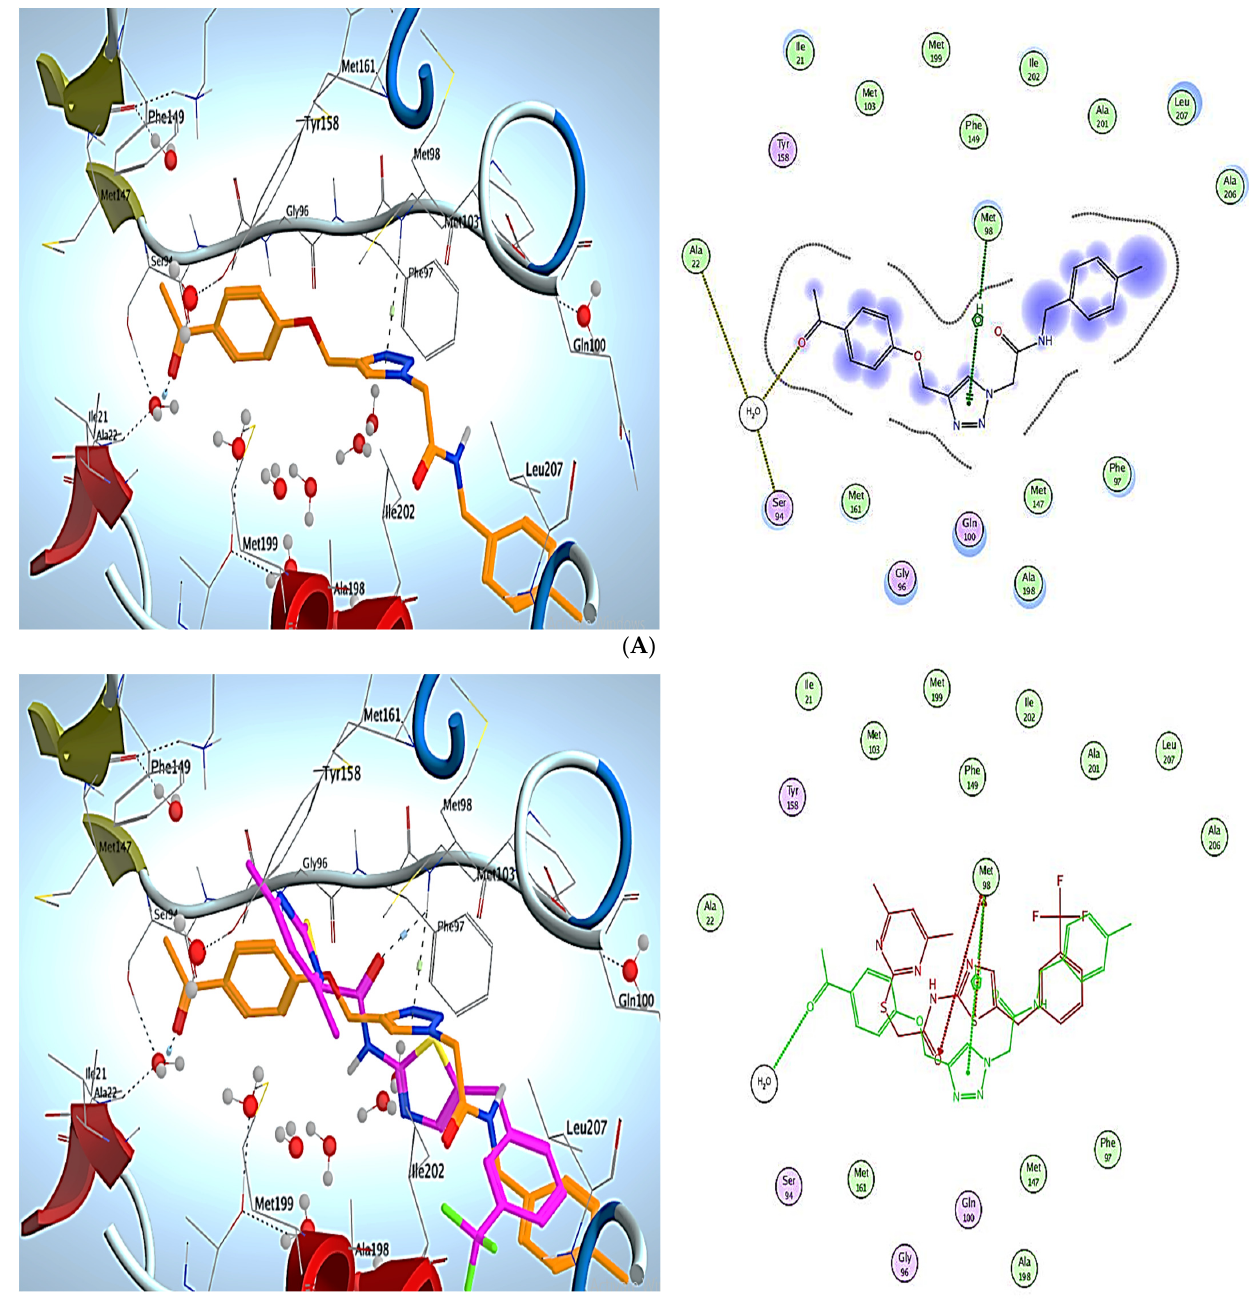
Figure 10. ( A ): Docking and binding pattern of compound 13 into InhA active site (PDB ID: 4UVD) in 2D (right panel) and 3D (left panel). ( B ): An overlay of the docked pose of compound 13 (brown) with the co-crystallized ligand (purple) into InhA active site in 2D (right panel) and 3D (left panel).